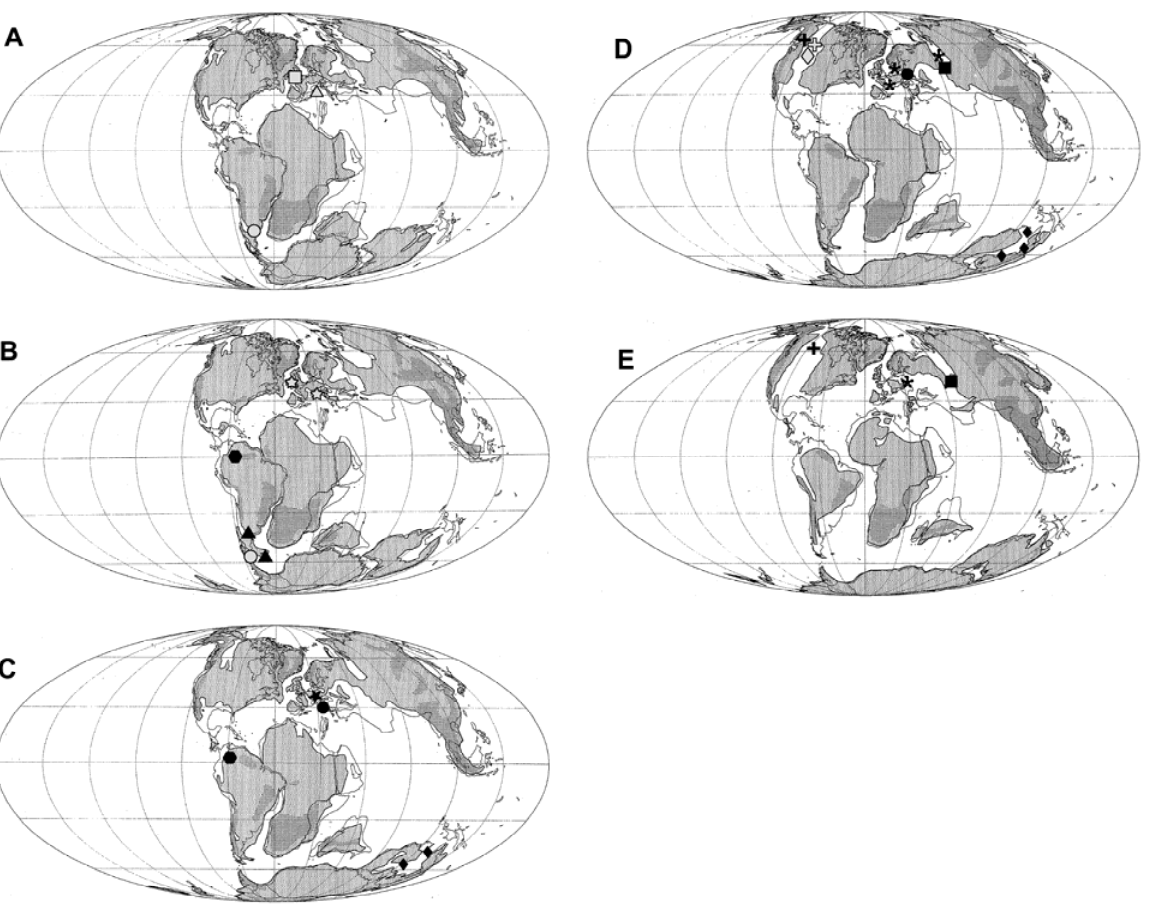
Figure 1. Cretaceous ichthyosaur occurrences for the ( A )